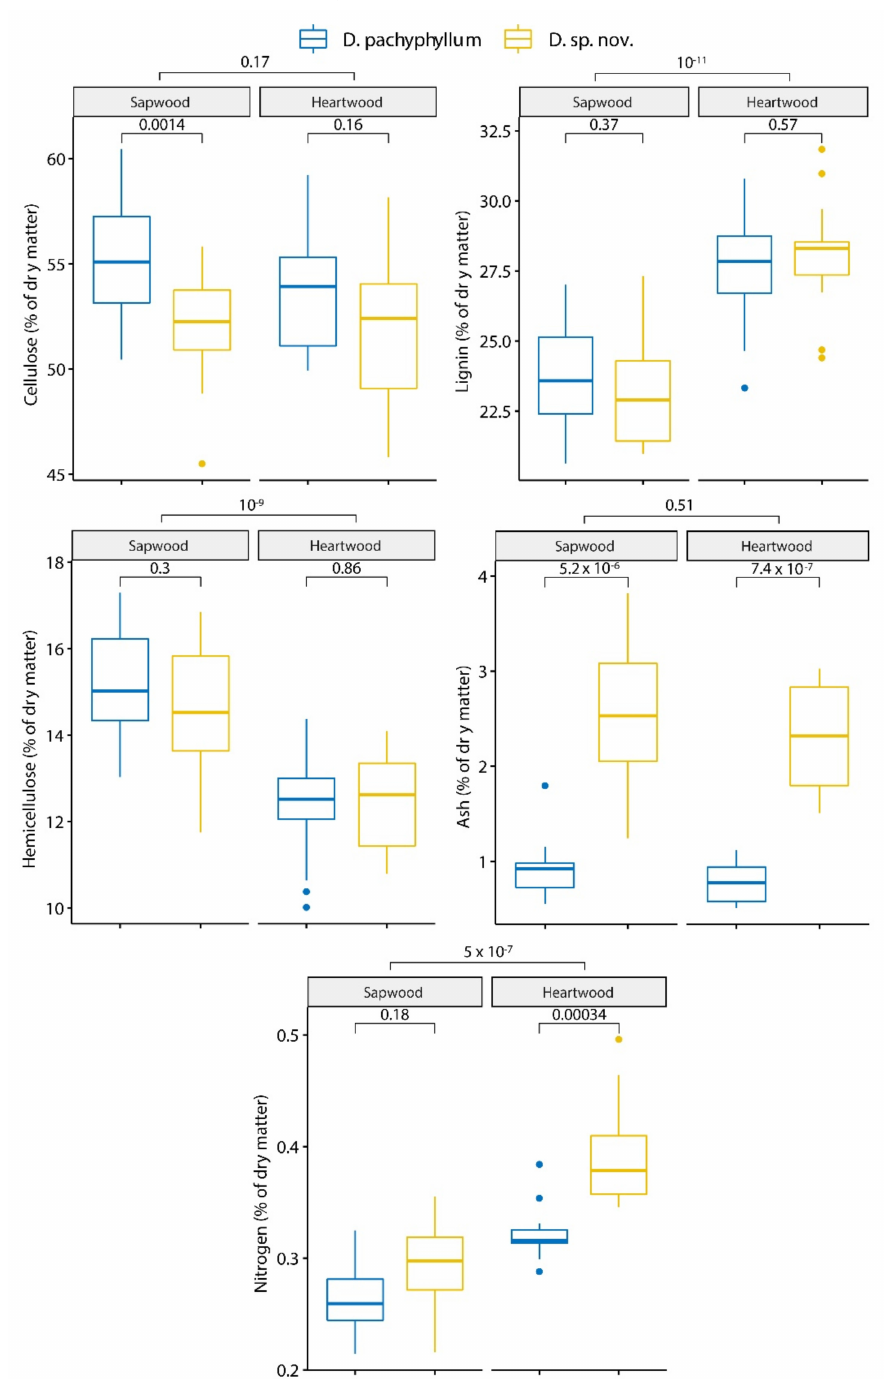
Figure 4. Primary metabolite’s variation in heartwood and sapwood among the different studied species; p -values concerning heartwood and sapwood are related to ANOVA test (Cellulose, Lignin and Hemicellulose) and Kruskal–Wallis test (Ash and Nitrogen); p -values that compare species are related to the t -test (Cellulose, Lignin and Hemicellulose) and Wilcoxon’s test (Ash and